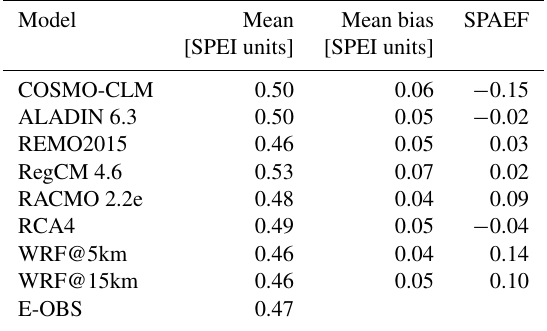
Table 9. Mean drought severity SPEI-3